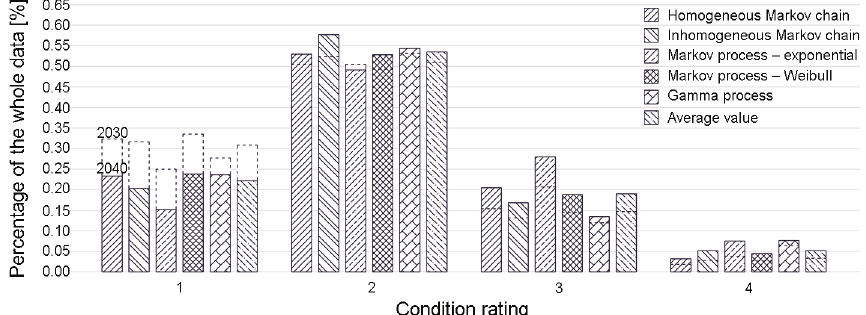
Fig. 2. Comparison of the predicted condition of bridge decks by year 2030 (striped) and 2040, expressed as the percentage of decks being in a certain condition state; with the presumption of no interventions being conducted in the